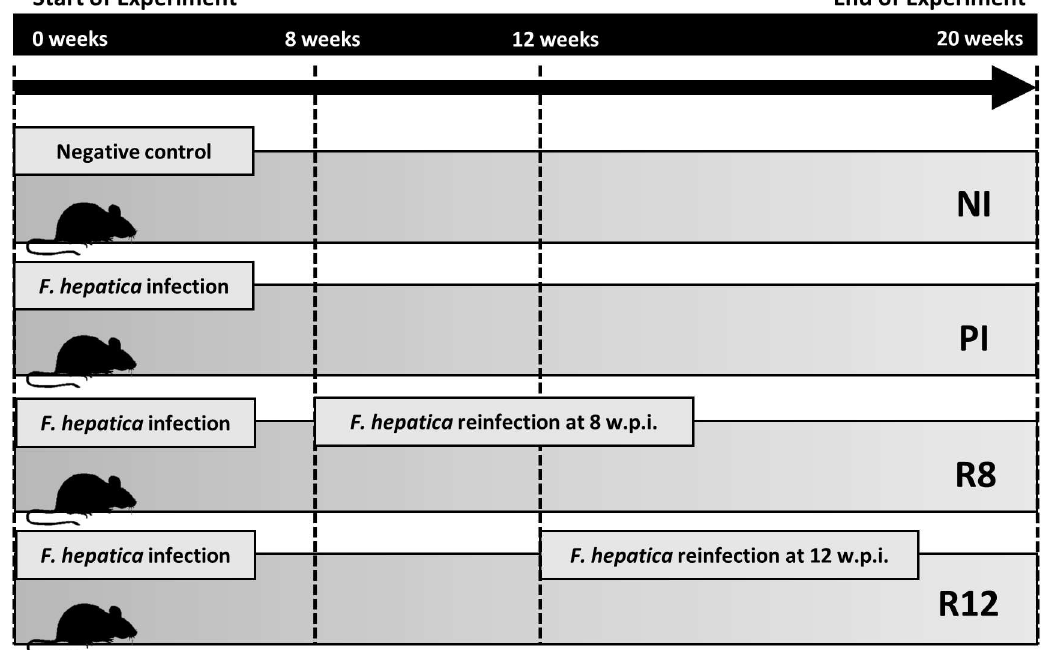
Fig 1. Experimental Design. Primary infected rats (PI): receiveda single infectiondose; reinfected rats (R): received a primary infectionand subsequently a secondary infection, at 8 weeks after primary infection(R8) and at 12 weeks after primary infection(R12); control rats (NI); all rats were sacrificed20 weeks after initiation of the experiment.